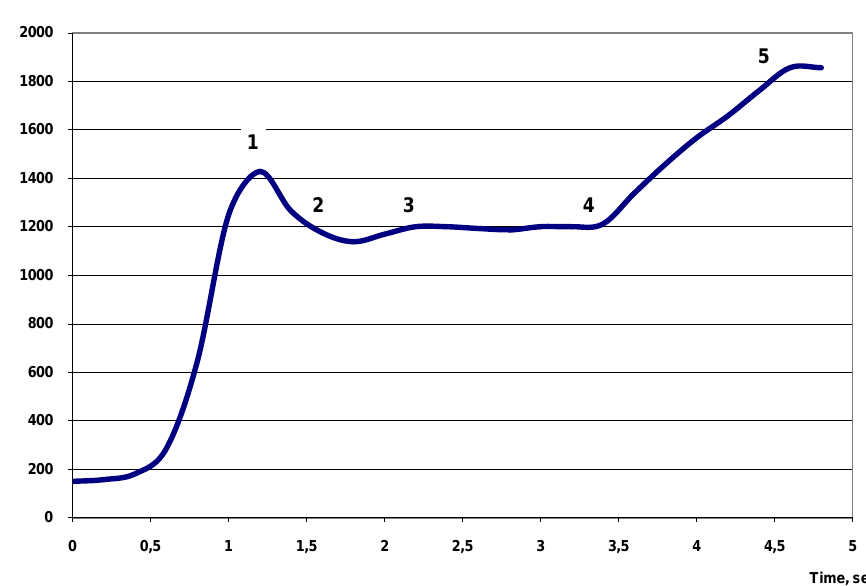
Diagram 3. Results of snatch with weight 75% from